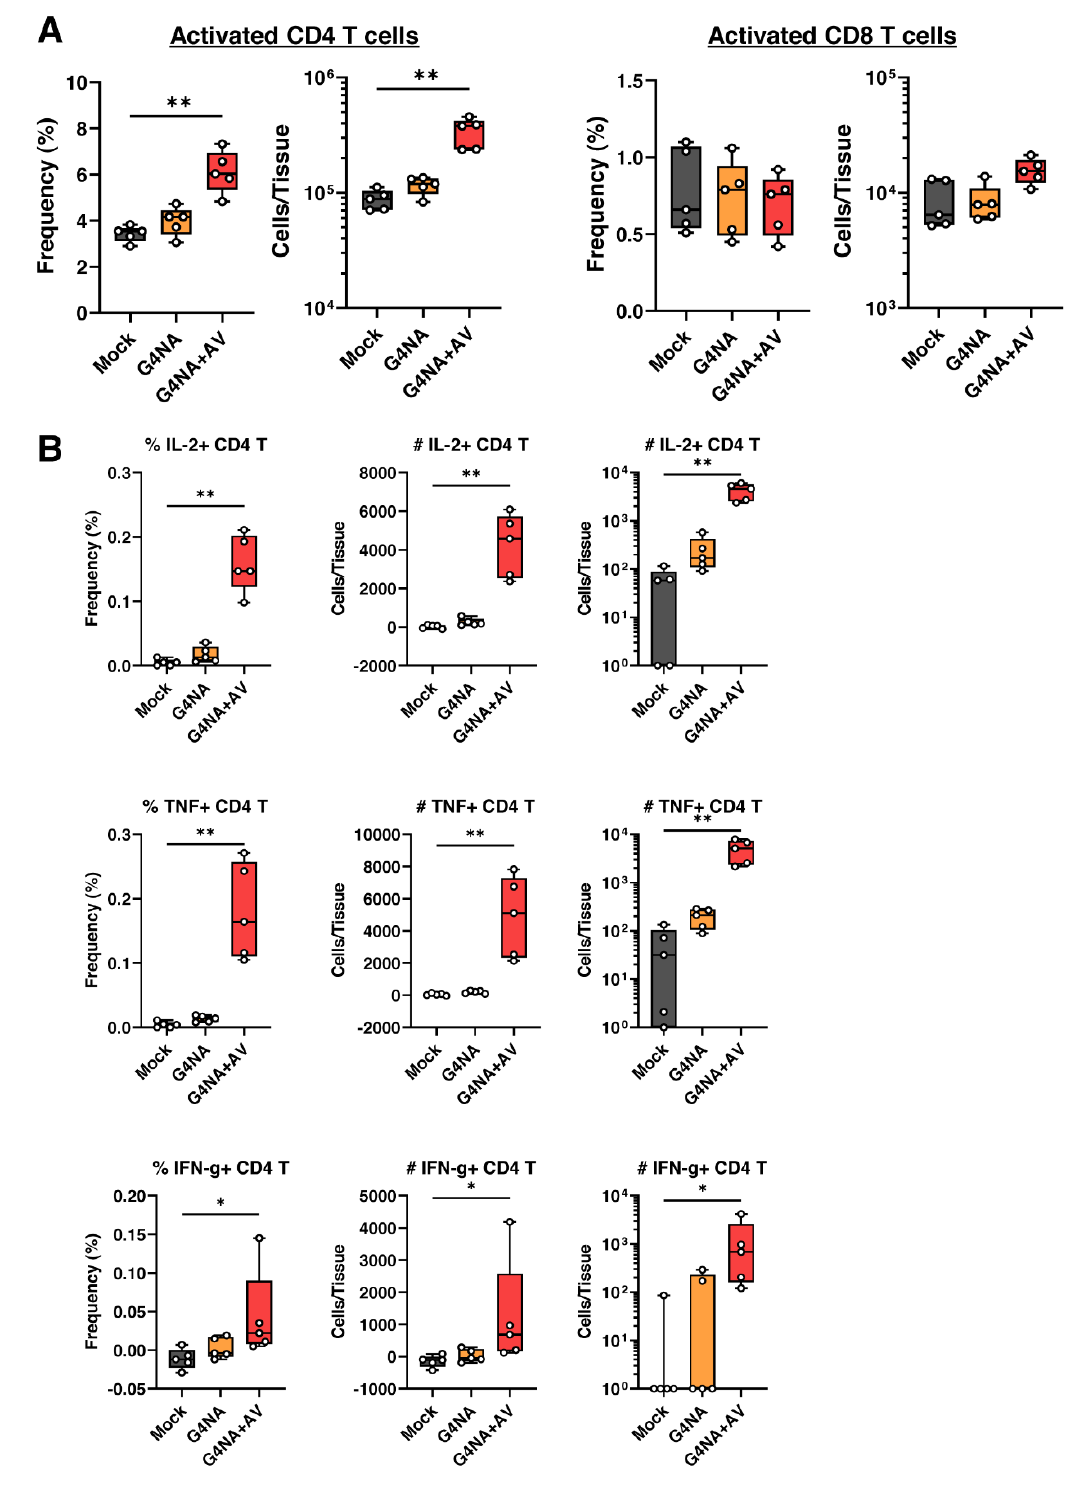
Figure 7. G4NA promotes CD4 T cell responses. ( A ) Frequencies (%) and cell numbers of activated CD4 T cells and activated CD8 T cells at day seven post-boost after vaccination with G4NA alone or with G4NA plus AV. ( B ) Frequencies (%) of TNF + /IL-2 + /IFN- γ + CD4 T cells in total CD4 T cells and total cell numbers (#) of each population. * p < 0.05, ** p < 0.01. Data are displayed as box plots showing median, 25 th and 75 th , percentiles, and the range.